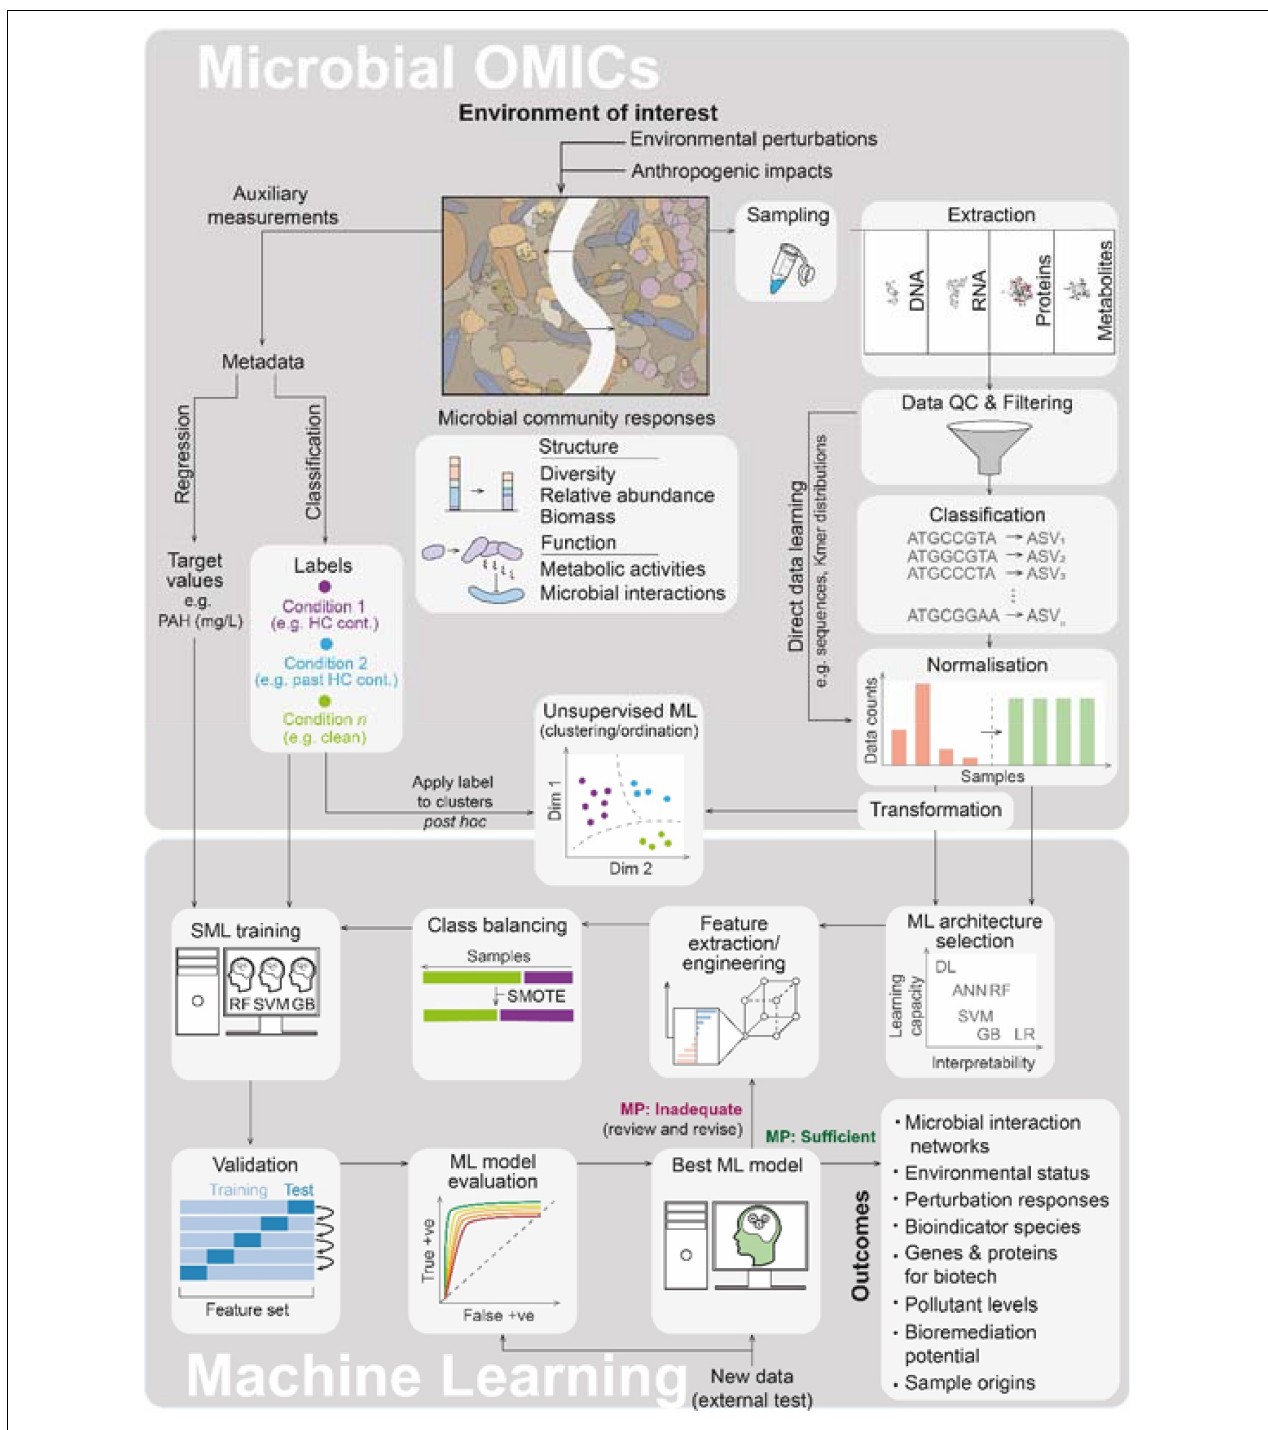
FIGURE 1 | The interface of microbial omics and machine learning (ML). A generalized and simplified overview of the workflows is presented highlighting the major steps in the microbial omics and ML workflows as they relate to one another along with key outcomes obtainable from the application of ML to omics data. Microbial community responses (biological information on which learning is aimed) are summarized below the cartoon snapshot of a contaminated environment of interest. Here, HC cont., hydrocarbon contamination; PAH, polyaromatic hydrocarbons (as examples of targets in petroleum hydrocarbon scenarios); QC, quality control; ASV, amplicon sequence variant (ASVs are given here as an example of an omics classification, other examples include the often used OTU, genes, mRNA transcripts, protein categories or metabolite IDs); DL, deep learning; ANN, artificial neural networks (shallow); RF, random forest; SVM, support vector machine; GB, gradient boost; LR, logistic regression; SMOTE, synthetic minority oversampling technique; SML, supervised machine learning; and MP, model performance.